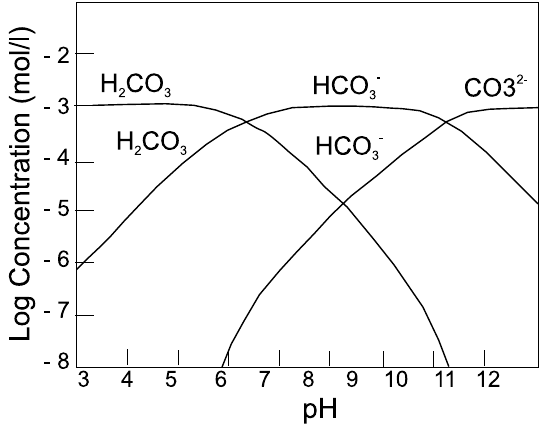
(cid:2) Fig. 5 – CO 2 (carbonate species) versus pH −